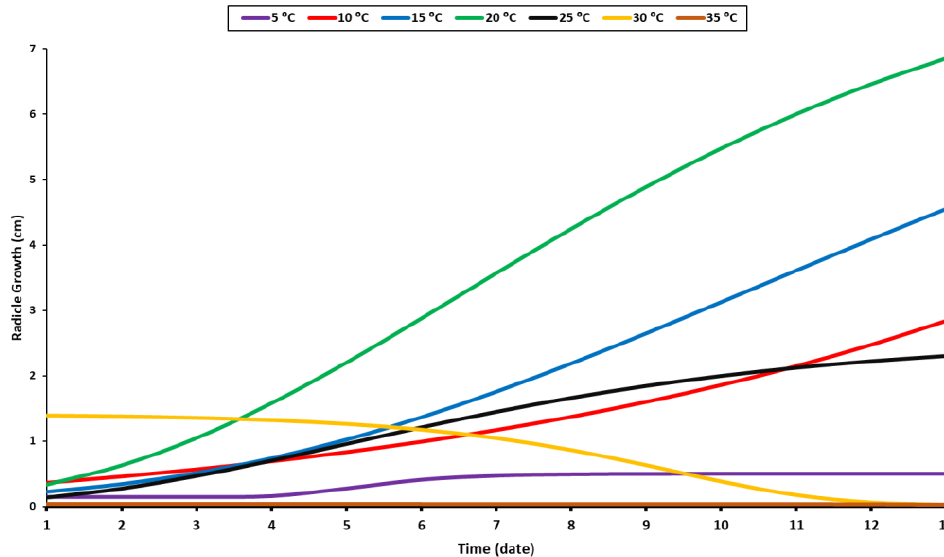
Figure 2. Growth response of radicle to temperature levels.